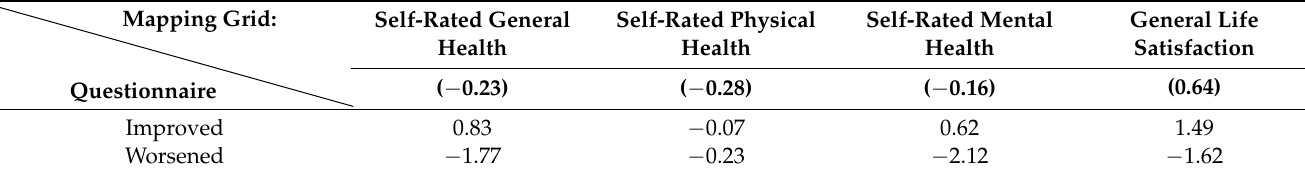
Table 3. Change in health status reported in the mapping grid by responses in the